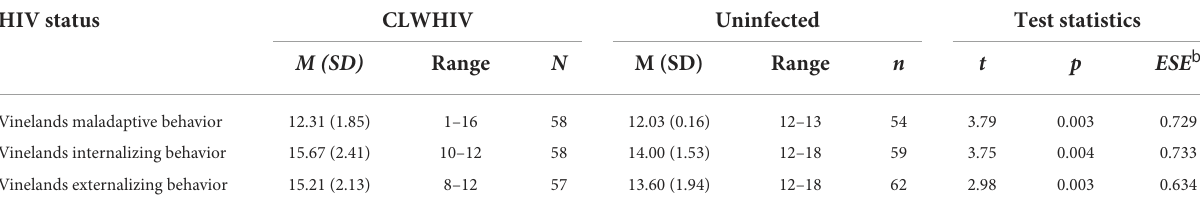
TABLE 6 Between group comparisons on the Vinelands Adaptive Behavioral Functioning: Maladaptive behavior subscale a . HIV status